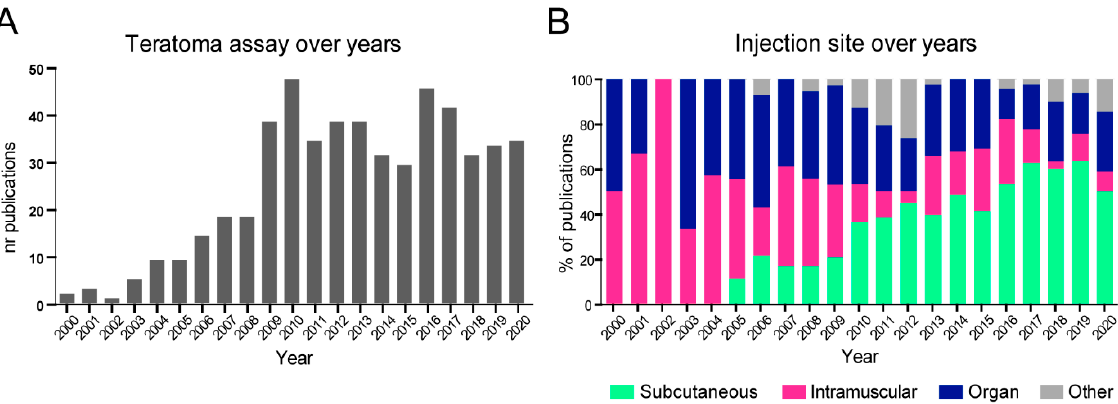
Figure 5 . Teratoma assay over the years. ( A ) Number of publications reporting use of teratoma assay per year, from 2000 to 2020. ( B ) Overview of anatomical injection sites used to inject cells (from 2000 to 2020).